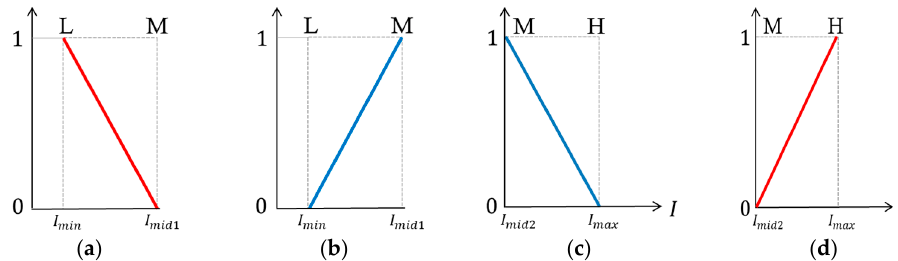
Figure 2. Fuzzy membership functions for lower and upper limits. ( a ) Lower limit (dec.), ( b ) lower limit (inc.), ( c ) upper limit (dec.), ( d ) upper limit (inc.).